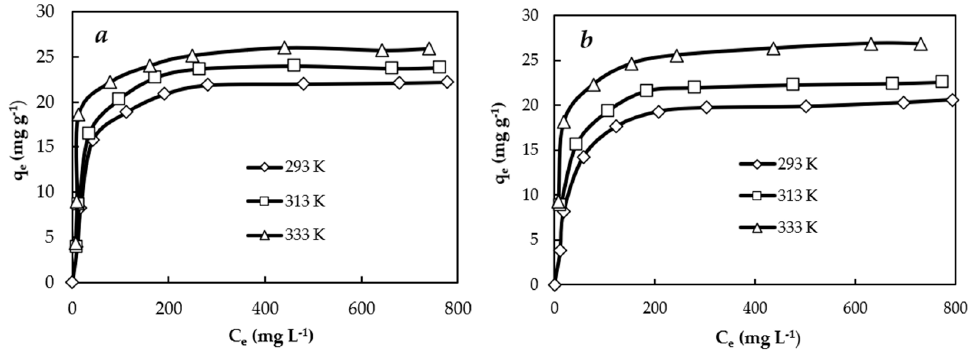
Figure 3. Adsorption isotherms of MB ( a ) and MG ( b ) on CS-C at different temperatures. Adsorption isotherm models help to describe the interaction between an adsorbent and the given adsorbate, which is a critical factor in optimizing the use of adsorbents [17]. The calculated parameters of the Langmuir, Freundlich, and Temkin isotherms of the cationic dyes on CS-C are shown in Table